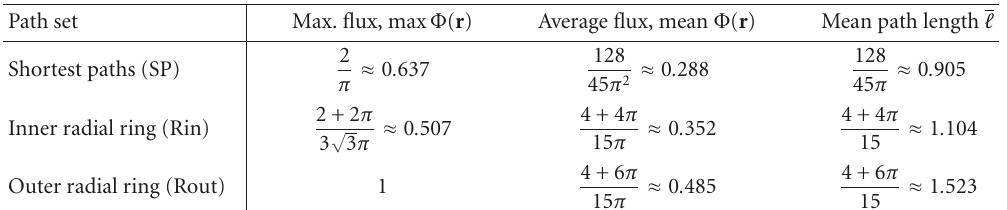
Table 1: Results with shortest and radial ring paths ( Λ = 1).